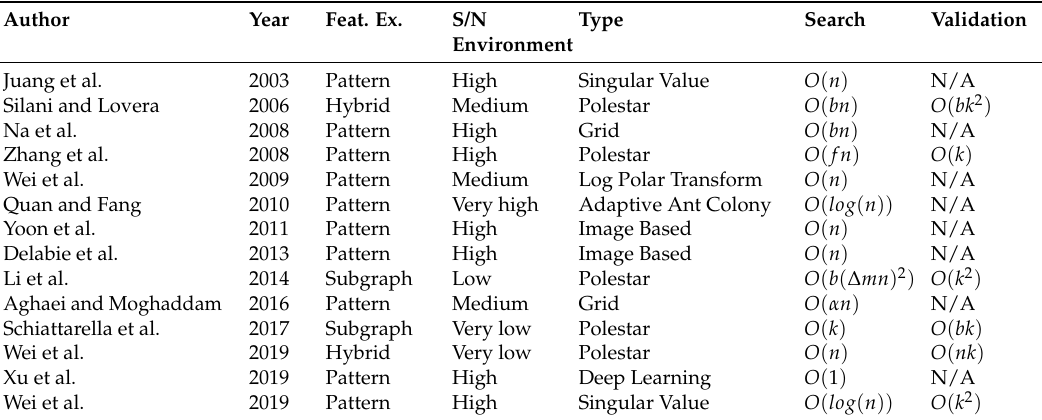
Table 1. Recent advancements of lost-in-space star identification